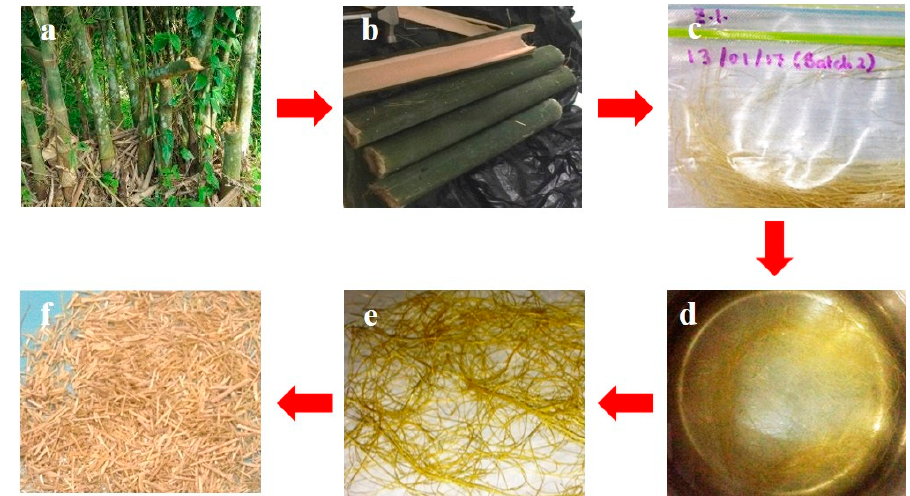
Figure 1. Fiber preparation starts with ( a ) selecting suitable bamboo plant, ( b ) followed by cutting, and ( c ) manually separating fibers. Fibers are sequentially ( d ) boiled, ( e ) dried, and ( f ) cut to size. The fiber extraction process starts with identifying bamboo plants free from mildew, discoloration, and dried portions. Internode sections, each 35 cm long, were cut from bamboo plants. Bamboo fibers were extracted manually and boiled in water for 5 h. The fibers were placed in an oven and dried at 100 ◦ C in air. After drying, fibers were cut into lengths of between 2 to 4 mm. Fibers were stored in a sealed vacuum bag between process steps and prior to